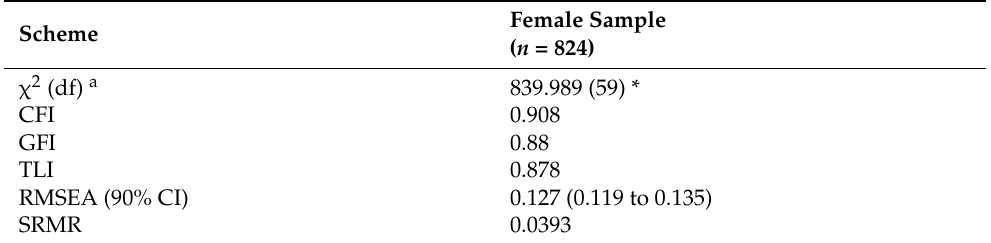
Table 3. Goodness-of-fit Indices for Athletes’ Perceived Body Pressures from Coaches Questionnaire for